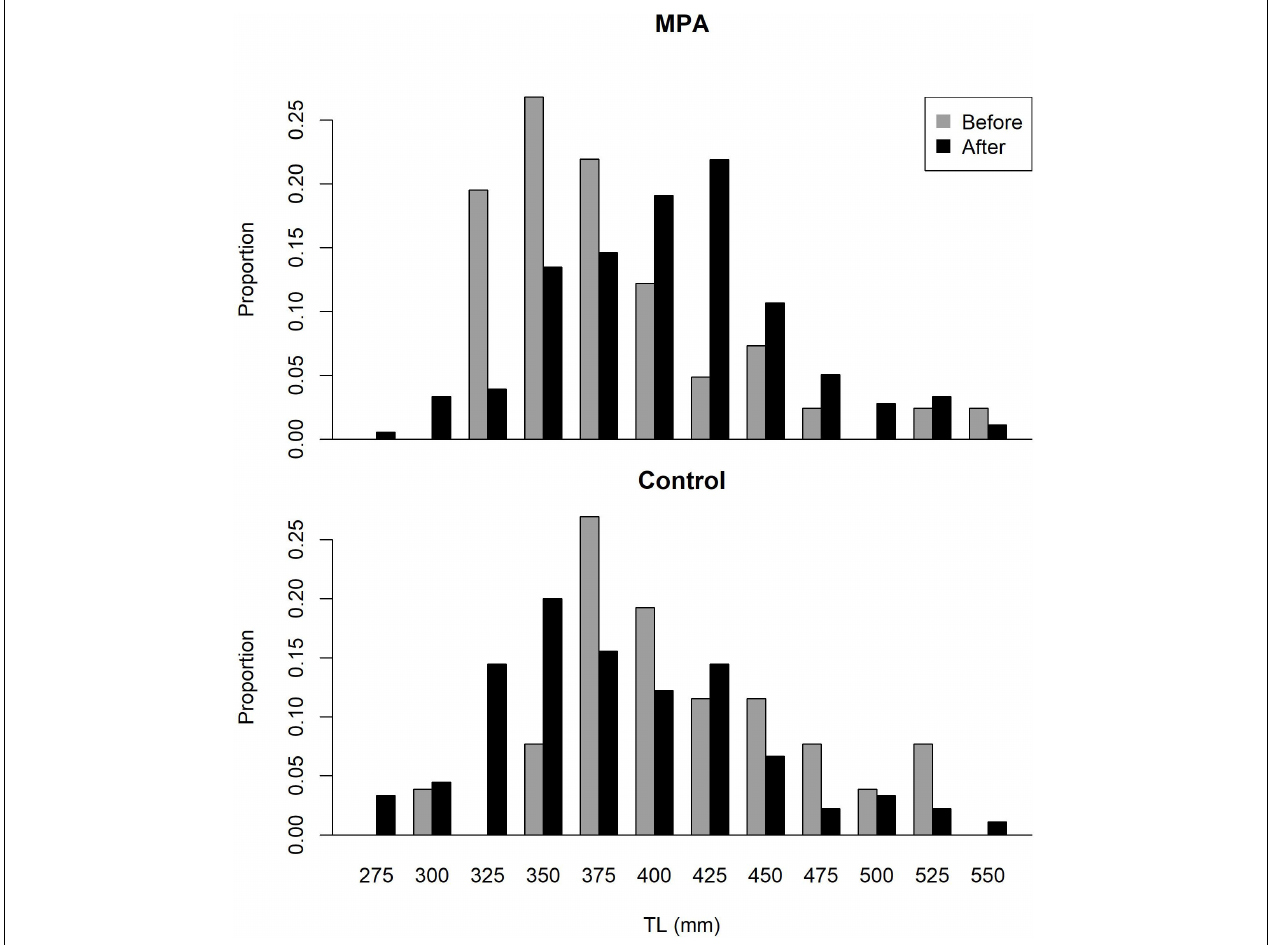
FIGURE 6 | Size (total length) distributions for red porgy caught in the Snowy Wreck Marine Protected Area (SWMPA) and the adjacent control area in the before period (2007–2009) by Rudershausen et al. (2010) and in the present study (after;